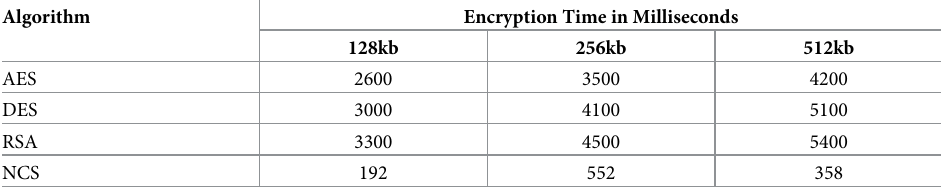
Table 5. Comparing encryption time of proposed (NCS) algorithm with conventional algorithms using different key sizes.